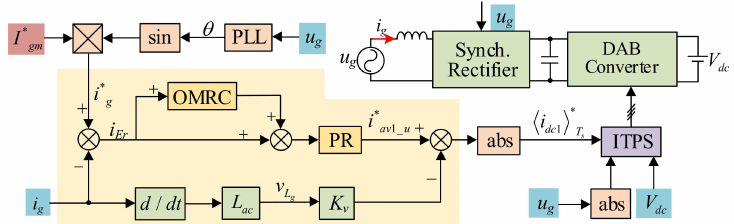
Figure 6. Schematic of the grid current closed-loop control strategy put